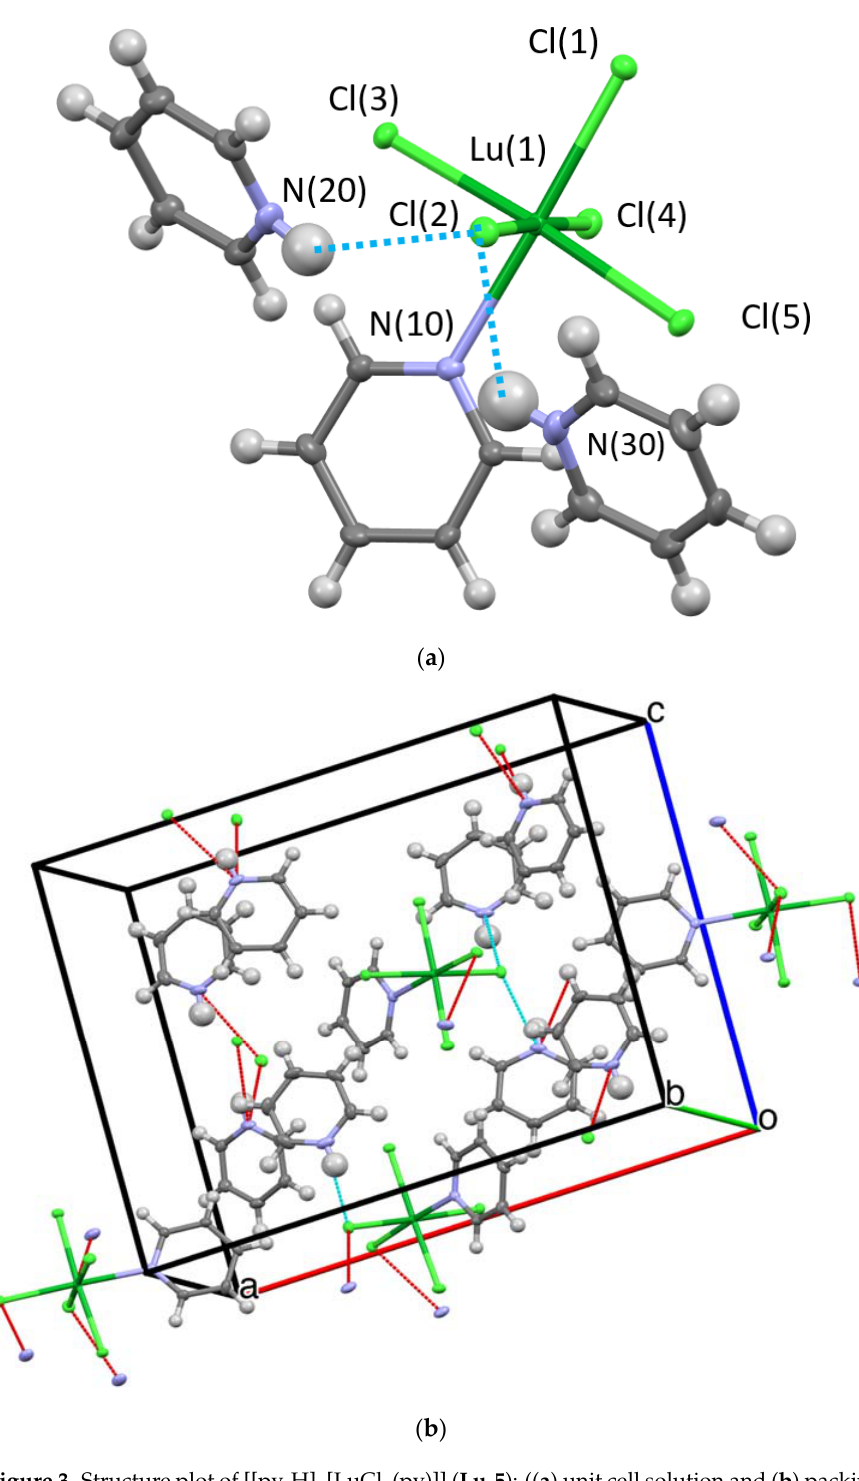
Figure 3. Structure plot of [[py-H] 2 [LuCl 5 (py)]] ( Lu-5 ): (( a ) unit cell solution and ( b ) packing diagram with H-bonding shown in blue dashes and short contacts in red. Thermal ellipsoids are drawn at 50% level. Blue dashed line represents H-bonding and red lines, short contacts.